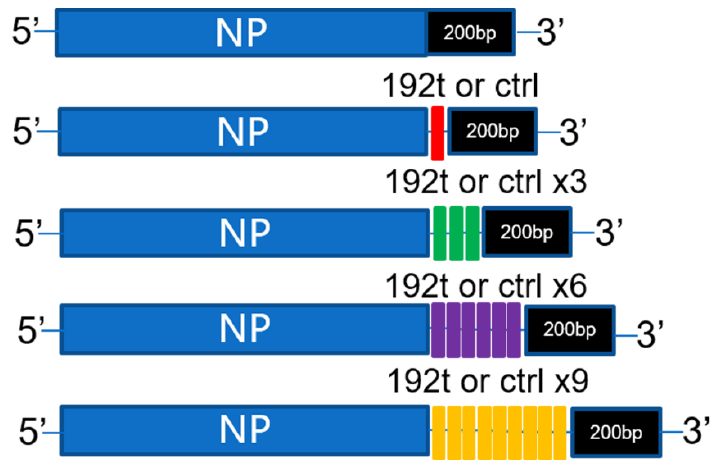
Figure 1. Generation of virus by insertion of di ff erent perfect miRNA target sites. Schematic illustrating NP and engineered NP viral segments. The downstream of the NP genome stop codon but upstream of the duplicated packaging sequence were inserted by di ff erent perfect miRNA-192-5p target sites or control target sites.